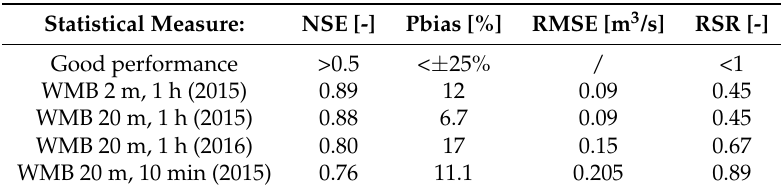
Figure 15. Discharge at the outlet, observed (yellow) vs. regressed (grey) for the Watermaelbeek catchment (20 m, 10 min) in ( a ) August and ( b ) November 2015. Table 5. Statistical performance measures to evaluate the discharge estimation after correcting for the above-mentioned reservoir occurrences